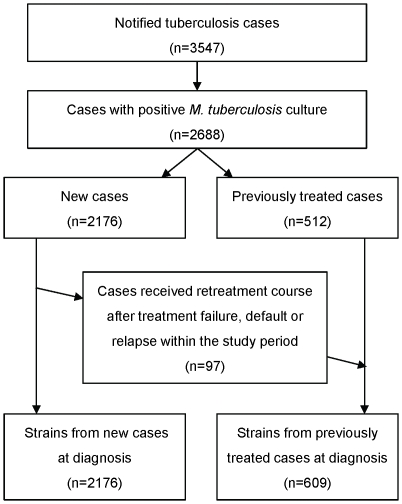
Flow diagram of tuberculosis subjects included in this study.